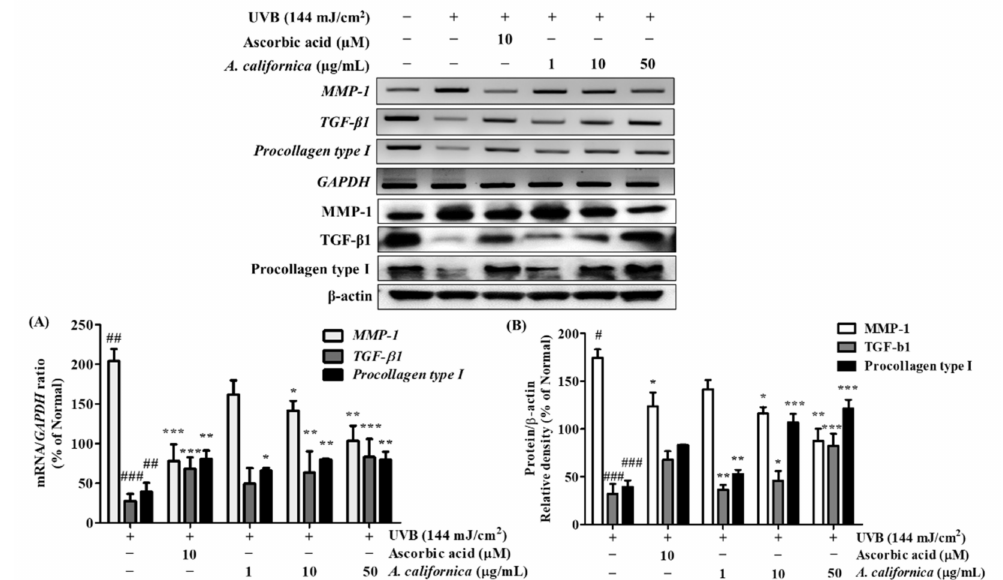
Figure 6. Effect of A. californica extract on mRNA ( A ) and protein ( B ) expression of MMP-1, TGF- β 1, and procollagen type I in UVB-irradiated HDF cells. Data are presented as the mean ± SD. # and * indicate significant differences from the non-irradiated control and UVB-treated groups, respectively. ## and ### p < 0.01 and 0.001 vs. the non-treated group, respectively. *, ** and *** p < 0.05, 0.01 and 0.001 vs. the UVB-treated control,